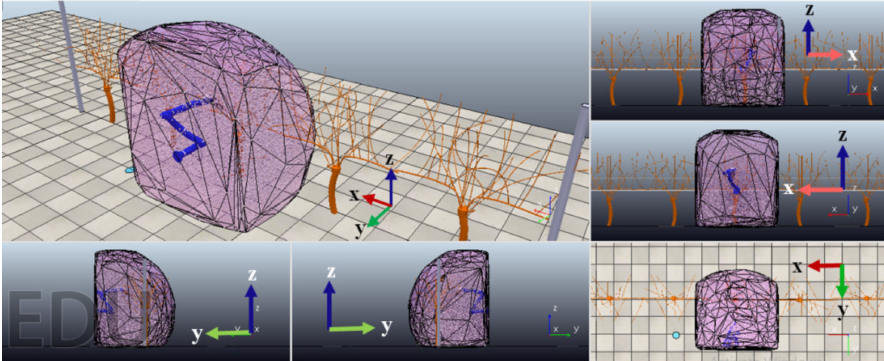
Figure 10. Prubot’s reachable workspace in different views.